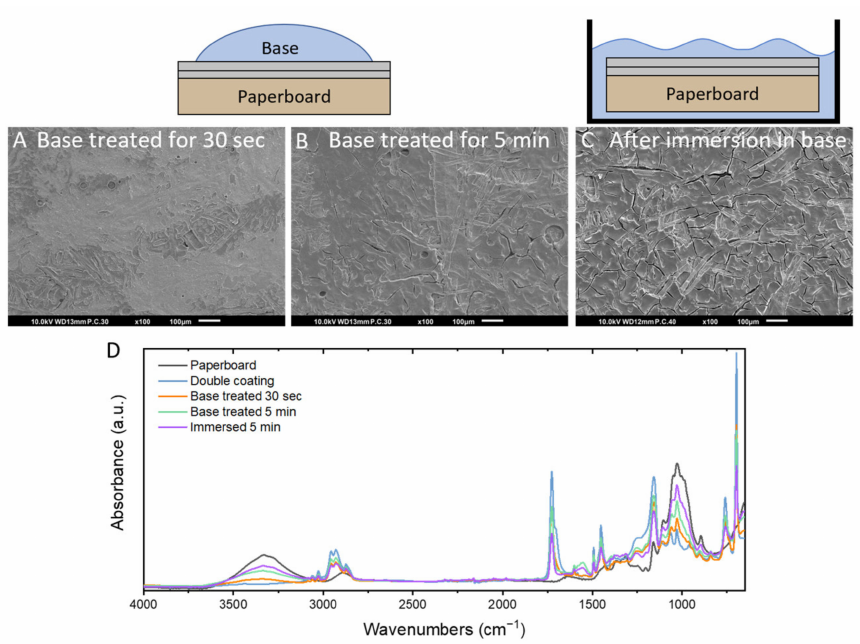
Figure 8. SEM images of the base-treated double-coated paperboard by placing a droplet of 0.1 M NaOH (aq) on top for ( A ) 30 s and ( B ) 5 min. Additionally, ( C ) the double-coated paperboard was immersed in 0.1 M NaOH solution for 5 min. ( D ) Corresponding FTIR spectra of the uncoated, double-coated paperboard and base-treated